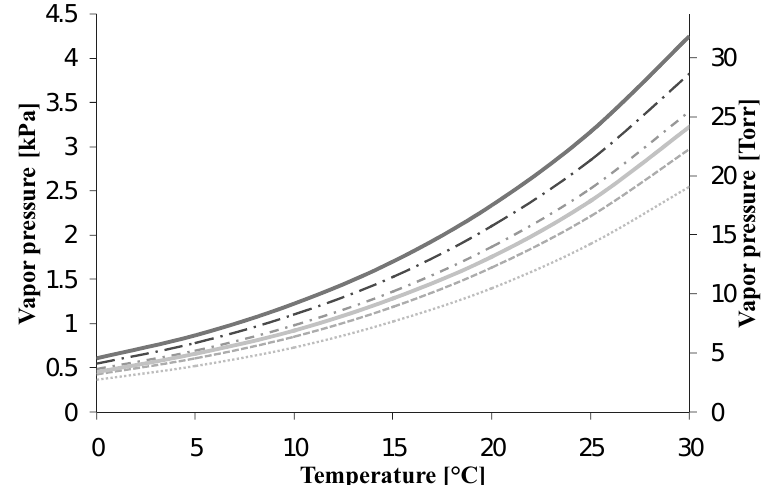
Fig. 2 Pressure-Temperature diagram of water (in dark continued line) (data from Mullin ʼ s book 6 ) and of saturated aqueous NaCl solution (in light dotted line) (data are adapted from Apelblat and Korin 7 ). Curves of water vapour pressure at 90%, 80%, 70% and 60% RH are represented in dotted lines from top to bottom,